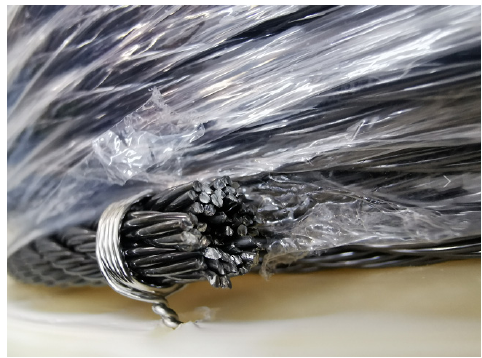
Figure 6. Superelastic NiTi SMA cable.